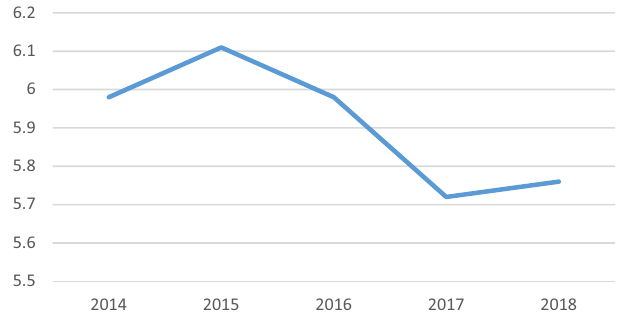
Figure 1. East Java rice crop productivity in 2014–2018 (Ton/Ha). Source: Central Bureau of